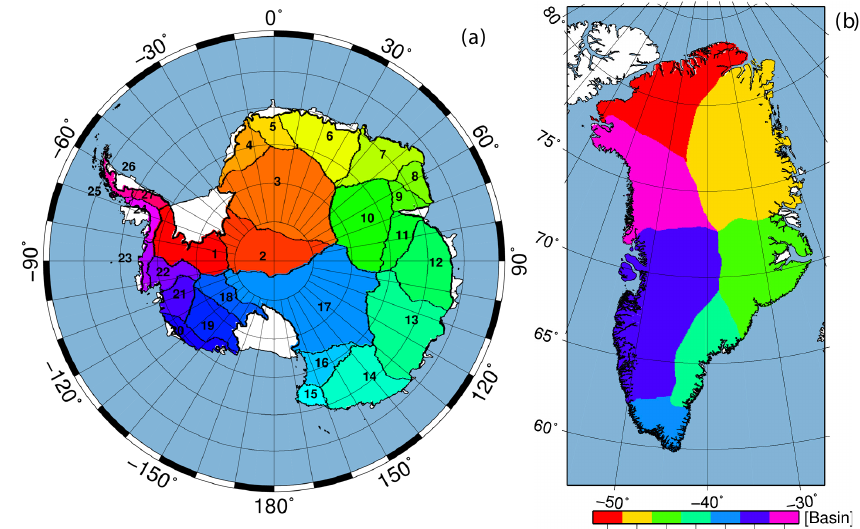
Fig. 3. Basin definitions for Antarctica (a) and Greenland (b) used in this